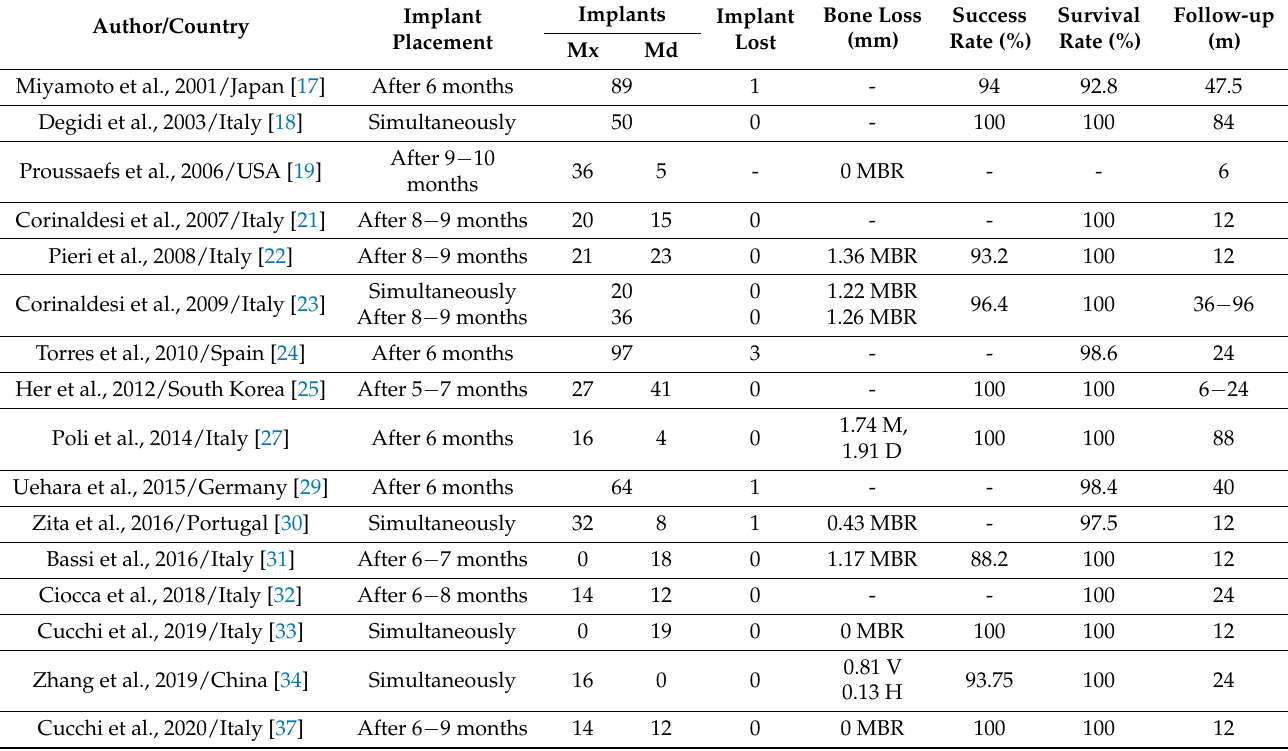
Table 5. Evaluation of characteristics of implant